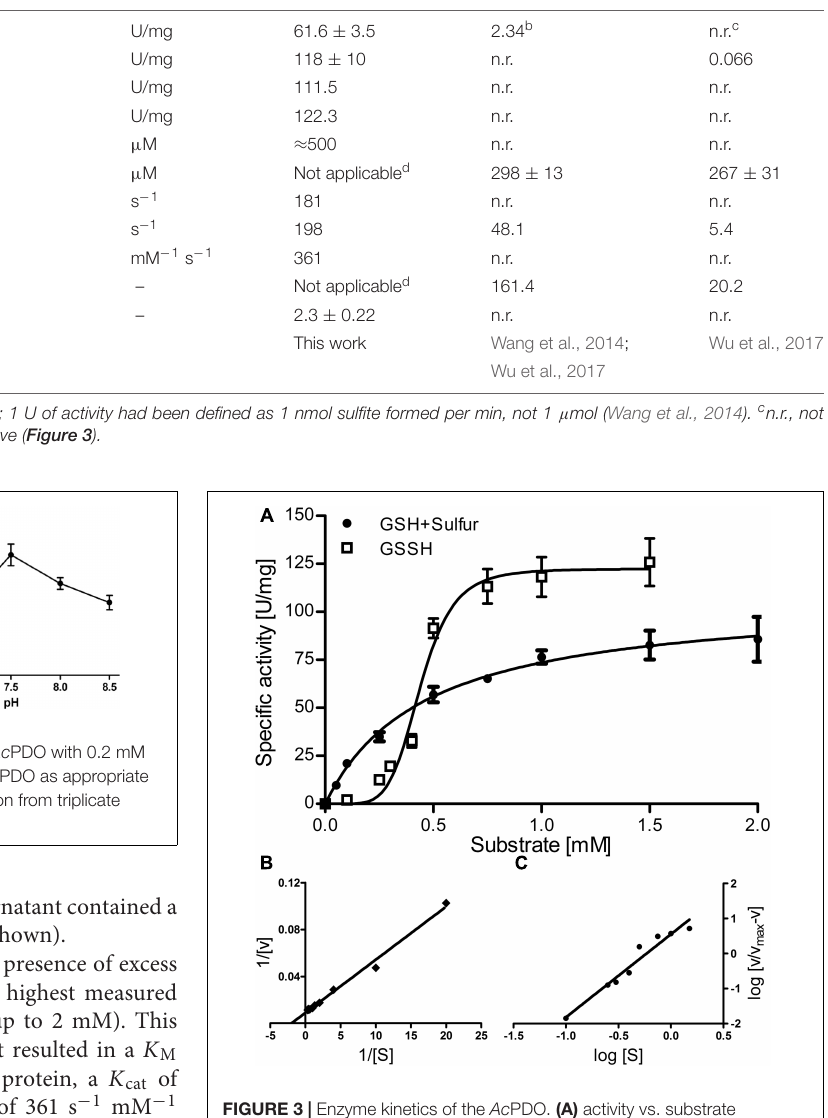
FIGURE 3 | Enzyme kinetics of the Ac PDO. (A) activity vs. substrate concentration plot for GSH plus sulfur and GSSH; Error bars represent the standard deviations from triplicate measurements. (B) Lineweaver–Burk plot for GSH plus sulfur; (C) Hill plot for